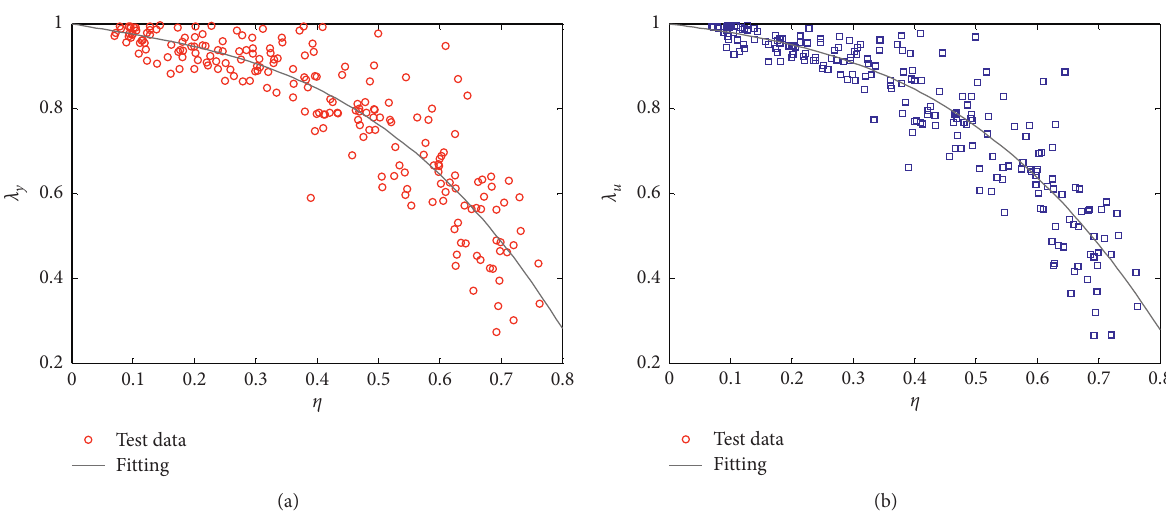
Figure 13: The degrading trend of mechanical properties with the increase of corrosion rate: (a) yield stress; (b) ultimate stress.